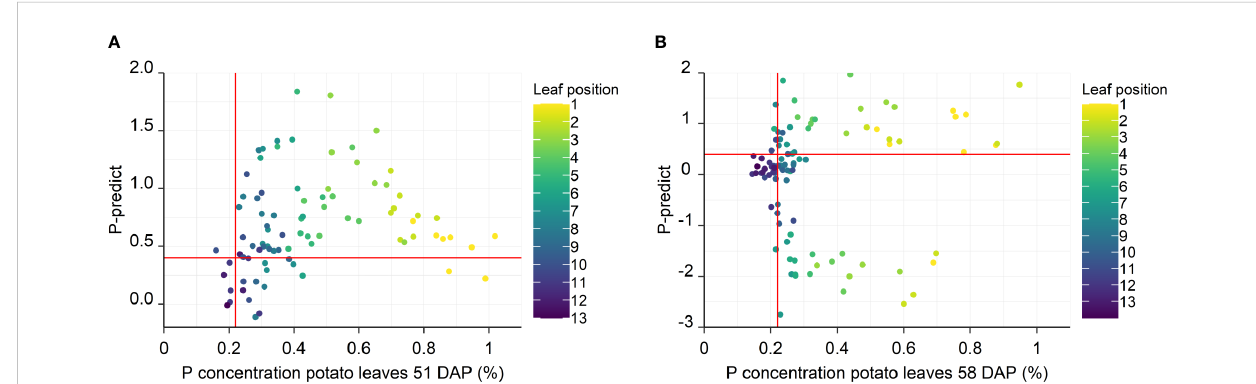
FIGURE 3 P-predict values correlated with the leaf P concentration at 51 DAP (A) and 58 DAP (B) . Each point corresponds to one measured leaf, color coded for leaf position. The vertical red line indicates the P concentration threshold for P de fi ciency at 0.22%, while the horizontal line represents the P- predict level indicating P de fi ciency at 0.4. Points located in the upper-left and lower-right are thus misclassi fi ed as being P suf fi cient or P de fi cient, respectively. 51 DAP: n = 90, 58 DAP: n =